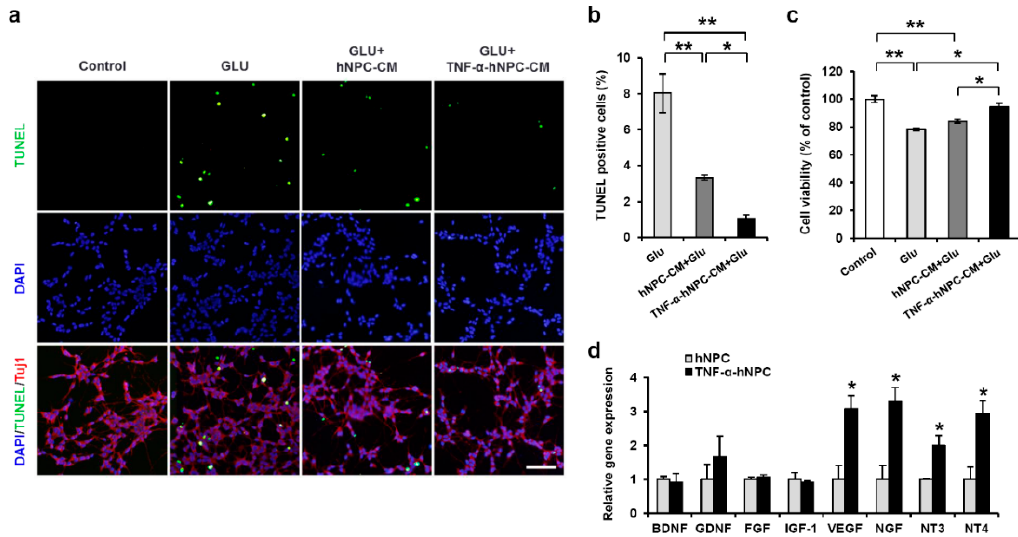
Figure 8. Secreted factors released from TNF- α pretreated hNPCs promoted survival of neuronal cells exposed to glutamate. ( a ) A TUNEL assay was used to measure apoptosis in neurons after glutamate exposure with hNPC-CM and TNF- α -hNPC-CM for 24 h. ( b ) Quantitative analysis of the TUNEL assay. TUNEL-positive cells were counted in four images of randomly chosen fields per group, and at least 100 cells were counted per field. Data are presented as the means ± SEM from three independent experiments performed in triplicate. ( c ) The viability of SHSY5Y cells was assessed by a CCK-8 assay after glutamate exposure with hNPC-CM and TNF- α -hNPC-CM for 24 h. ( d ) qRT-PCR was performed to quantify the mRNA expression of neurotrophic factors in hNPCs and TNF- α -hNPCs. * p < 0.05 and ** p < 0.01. Data are presented as the mean ± SEM.